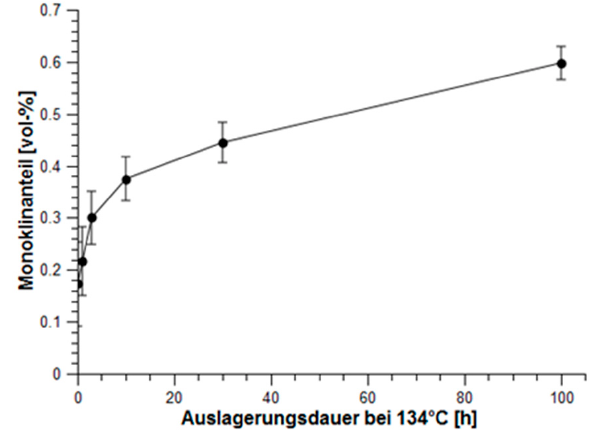
Figure 23. Increase of monoclinic phase–linearly.